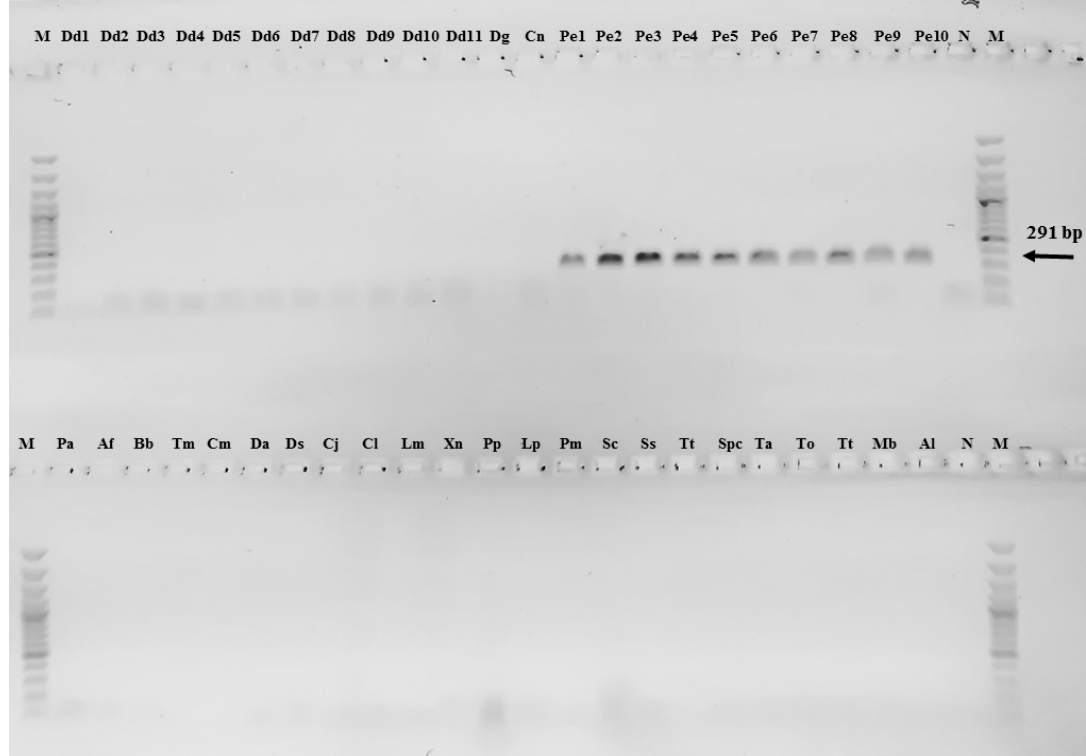
Figure 7. Gel electrophoretic image. End-point PCR amplification of NAD2 fragment in ten geographically disjunct specimens of P. erythrinus (lanes 14–35, from Pe1 to Pe10). No amplification was obtained for all other fish species (lanes 1–13 and 36–46). Abbreviations as in Tables 1–3. N: Negative control; M: 100 bp ladder.